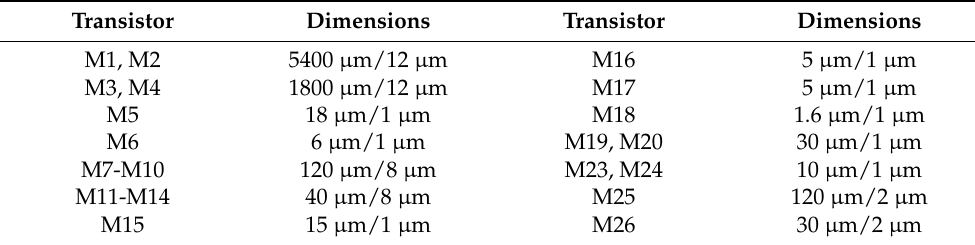
Table 4. Preamplification op-amp MOSFET